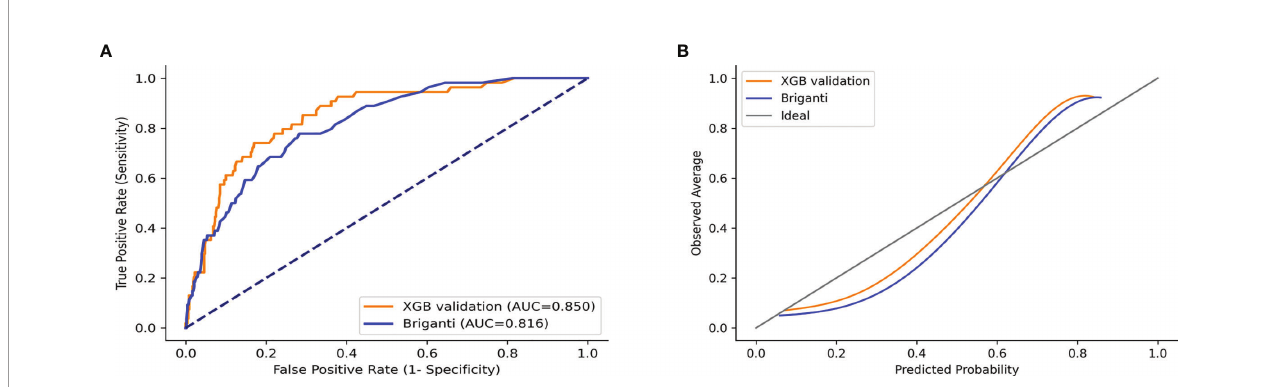
FIGURE 8 | ROC curves and calibration plots of XGB and Briganti nomogram for the validation set. (A) ROC curves. (B) Calibration